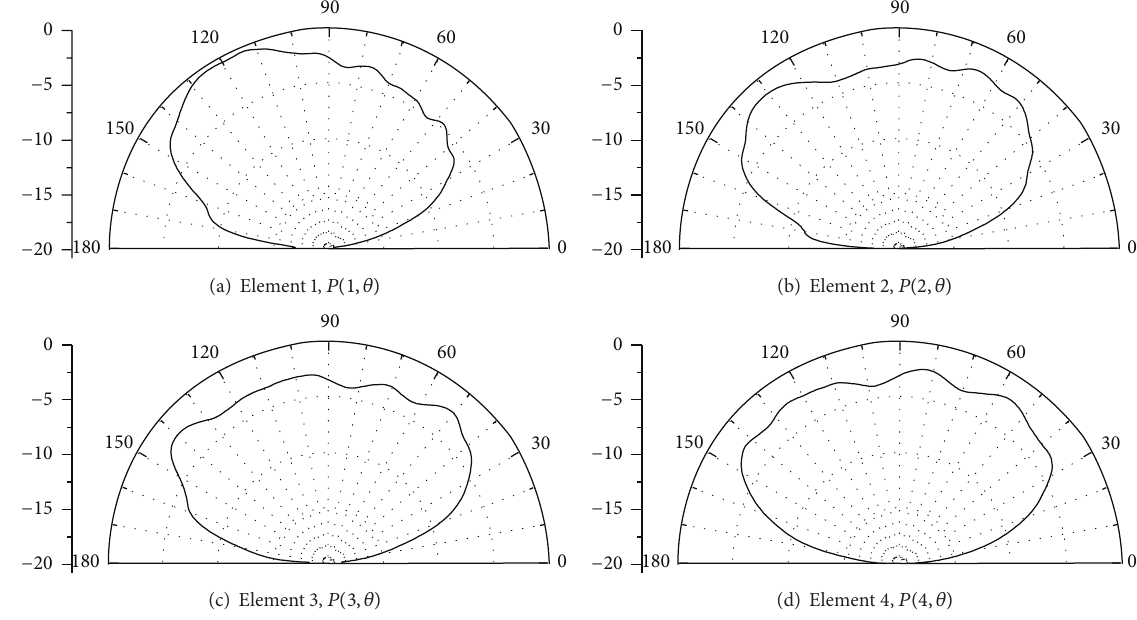
Figure 10: Measured normalized active element amplitude patterns of subarray 1 [denoted as 𝑃(𝑘,𝜃)